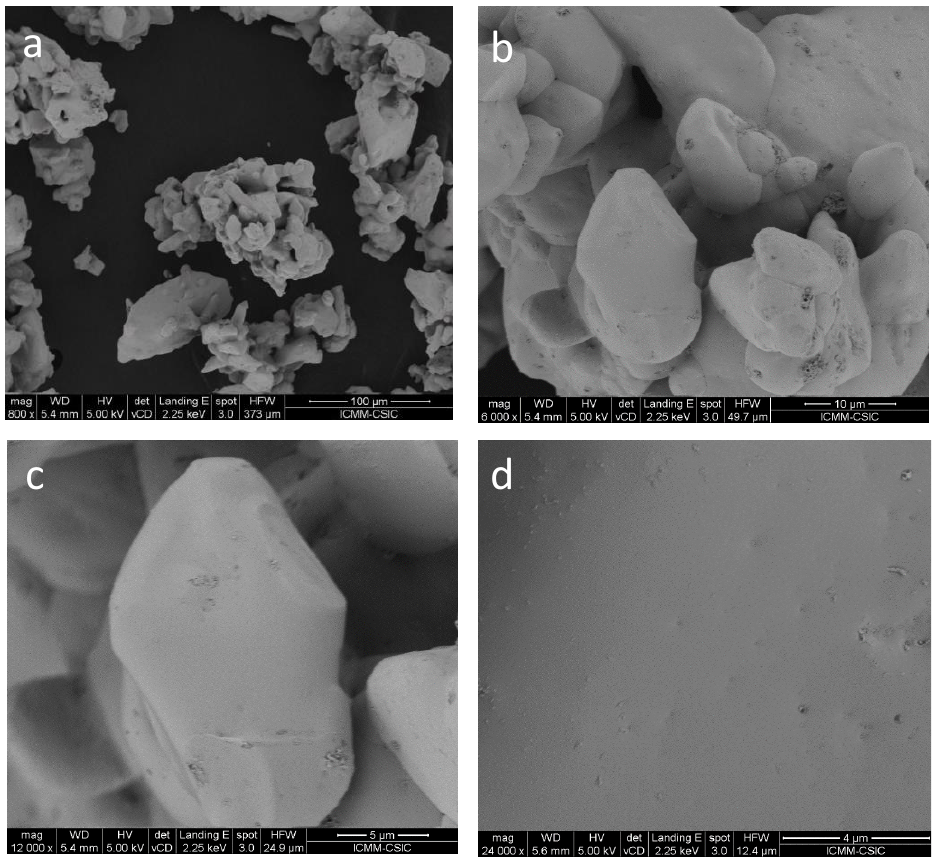
Figure 1. FE-SEM images of the MACdBr 3 collected with magnifications of ( a ) 800×, ( b ) 6000×, ( c ) 12,000× and ( d ) 24,000×.